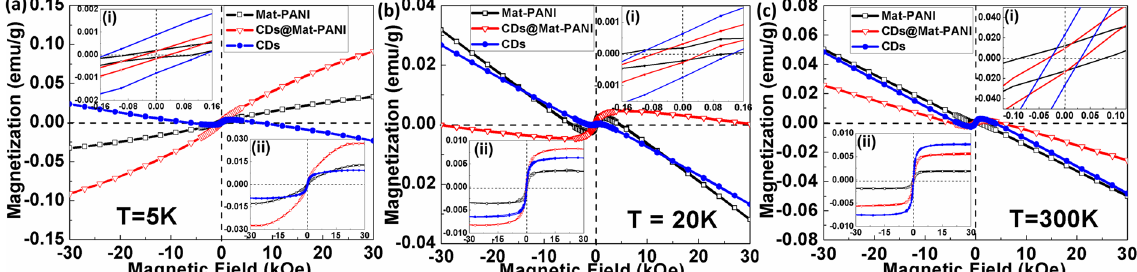
Figure 5. Magnetic hysteresis curves of the Mat-PANI, CDs@Mat-PANI and CDs at ( a ) 5 K, ( b ) 20 K, and ( c ) 300 K. The insets of ( a (i)), ( b (i)) and ( c (i)) show magnetic hysteresis curves of Mat-PANI, CDs@Mat-PANI and CDs in the range of ± 0.12 kOe. The insets of ( a (ii)), ( b (ii)) and ( c (ii)) show the hysteresis curves after subtracting the diamagnetic component.